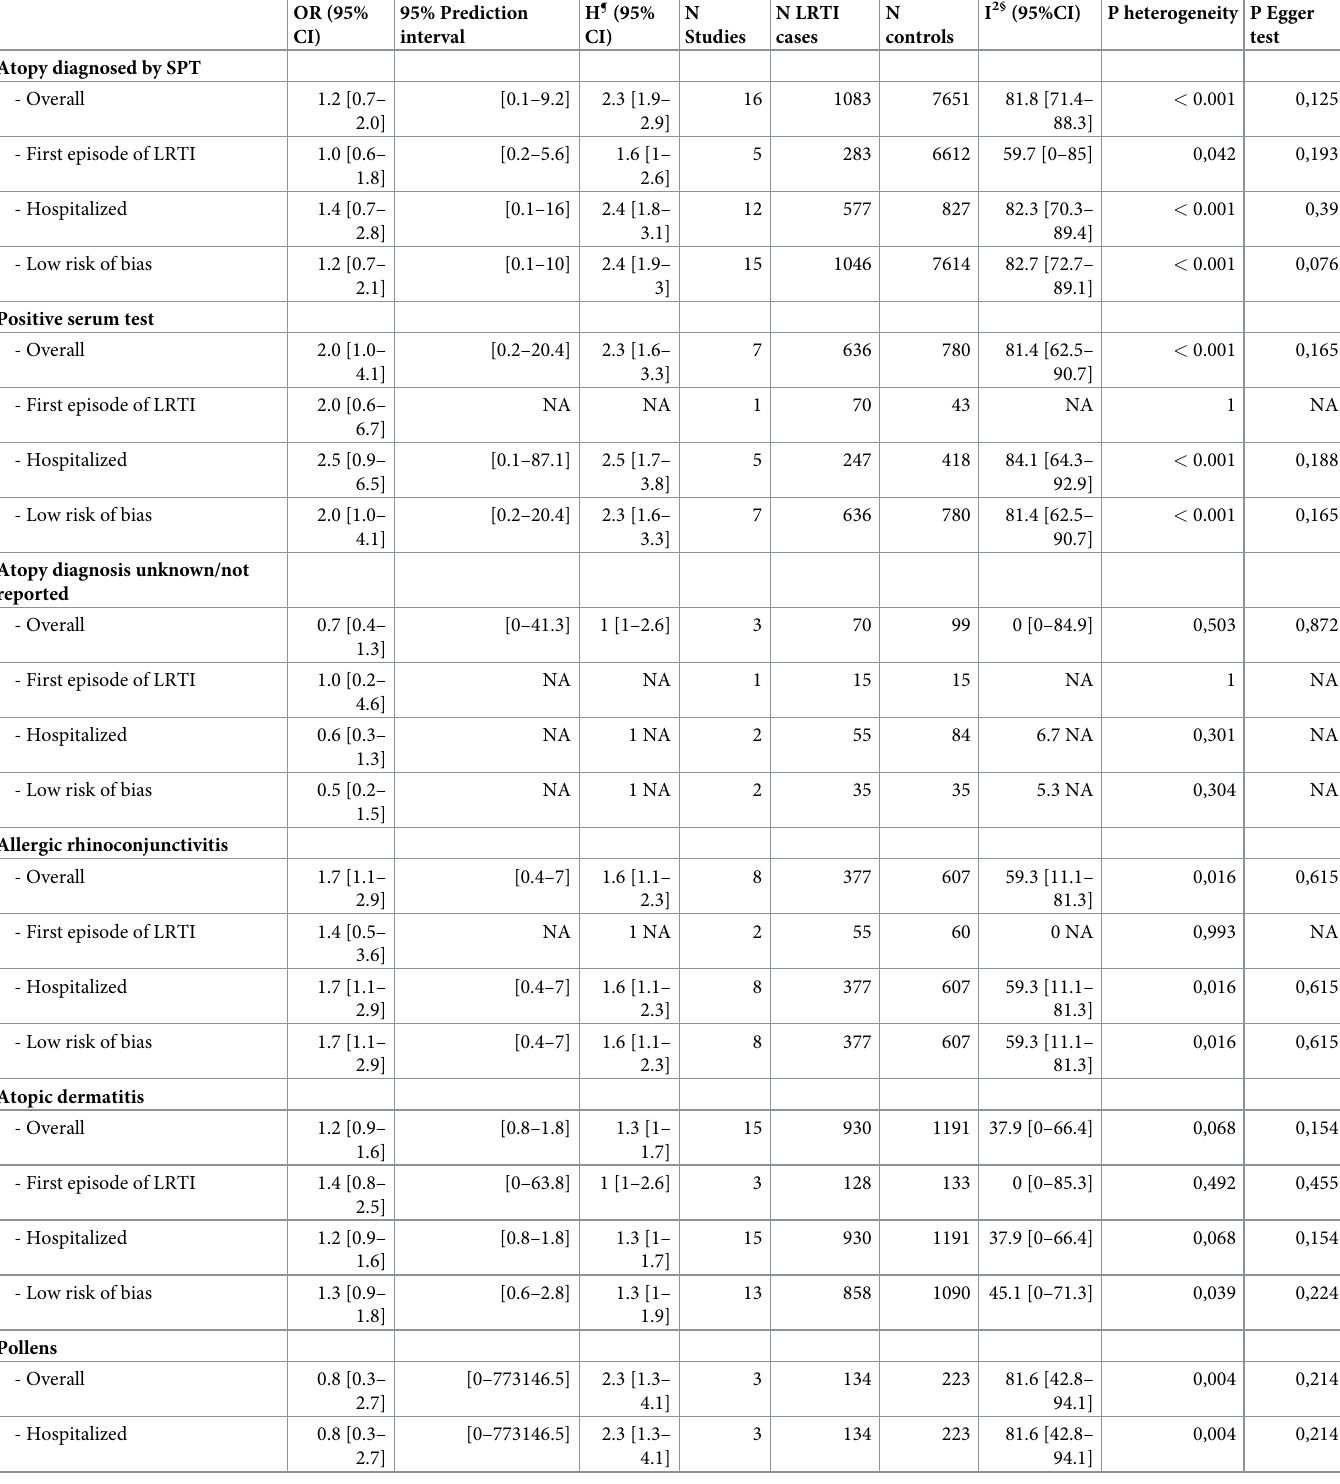
Table 2. Atopy development in children with and without lower respiratory tract infections in